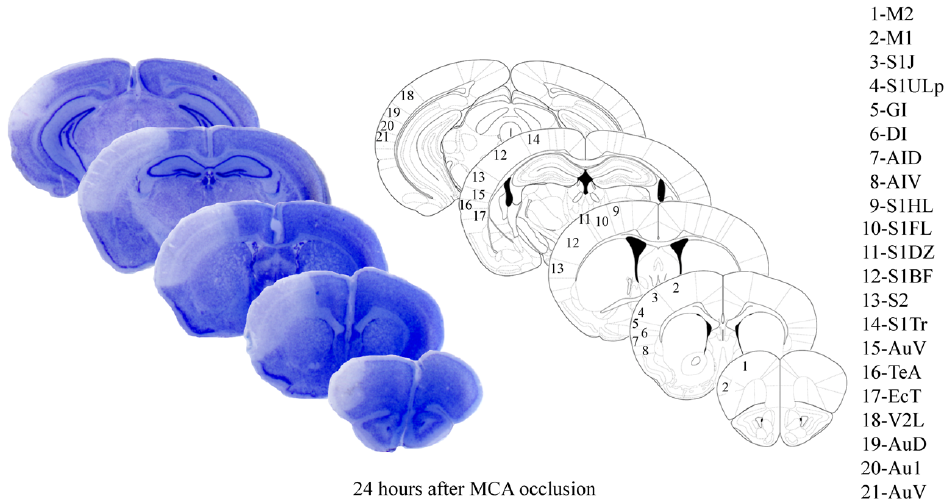
Figure 2. Nissl staining of representative mouse brain 24 h following right MCA occlusion and cortical regions involved